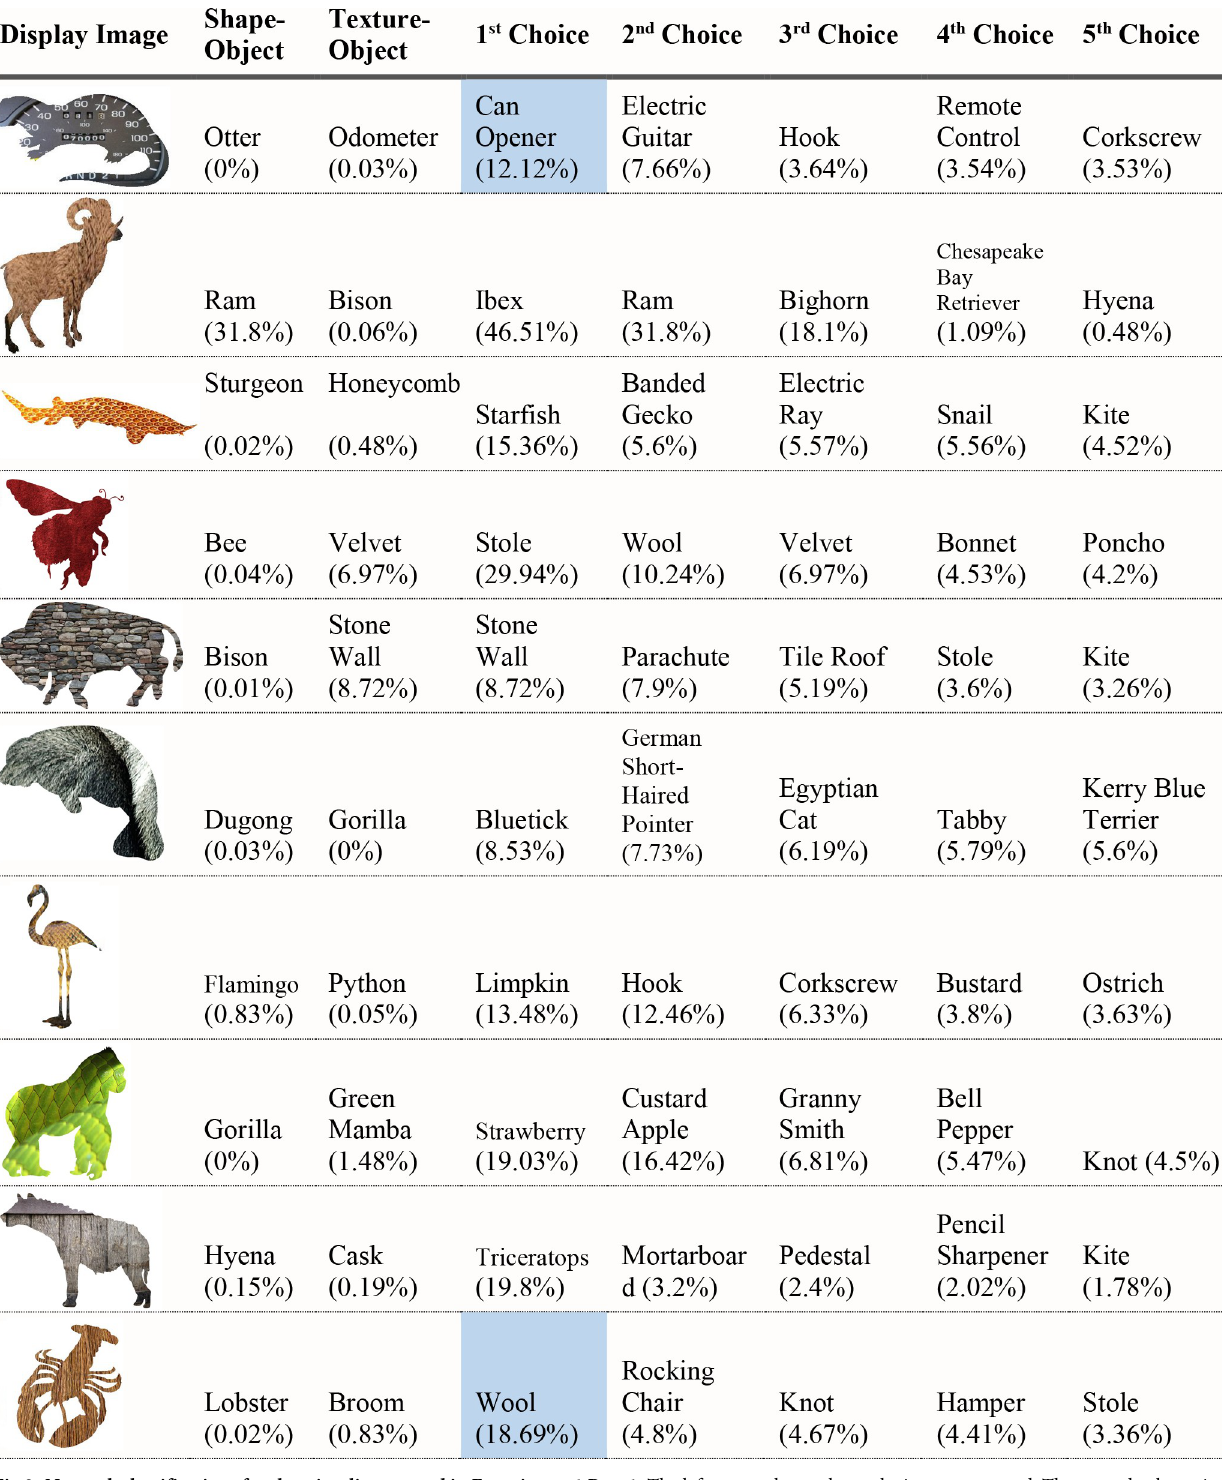
Fig 3. Network classifications for the stimuli presented in Experiment 1 Part 1. The left most column shows the image presented. The second column in each row names the object from which the shape was sampled. The third column names the object from which the texture silhouette was obtained. Probabilities assigned to the object name in columns 2 and 3 are shown as percents below the object label. The remaining five columns show the probabilities (as percents) produced by the network for its top five classifications, ordered left to right in terms of probability. Correct shape classifications in the top five are shaded in blue and correct texture classifications are shaded in